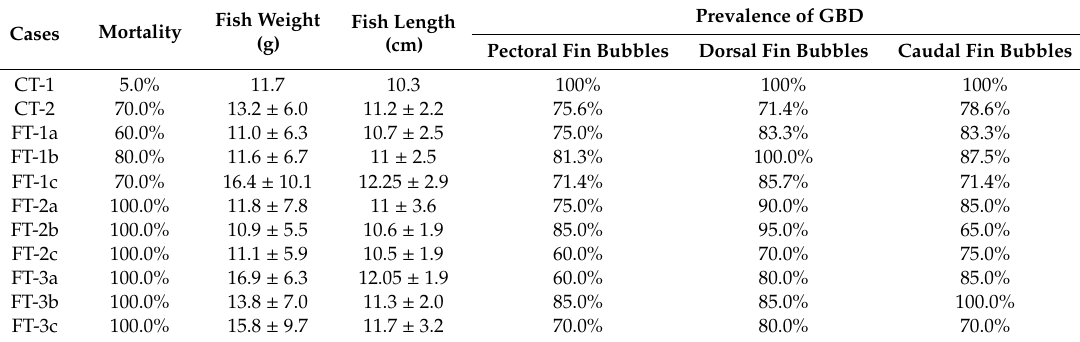
Table 2. The mortality and prevalence of typical gas bubble disease (GBD) in fish.